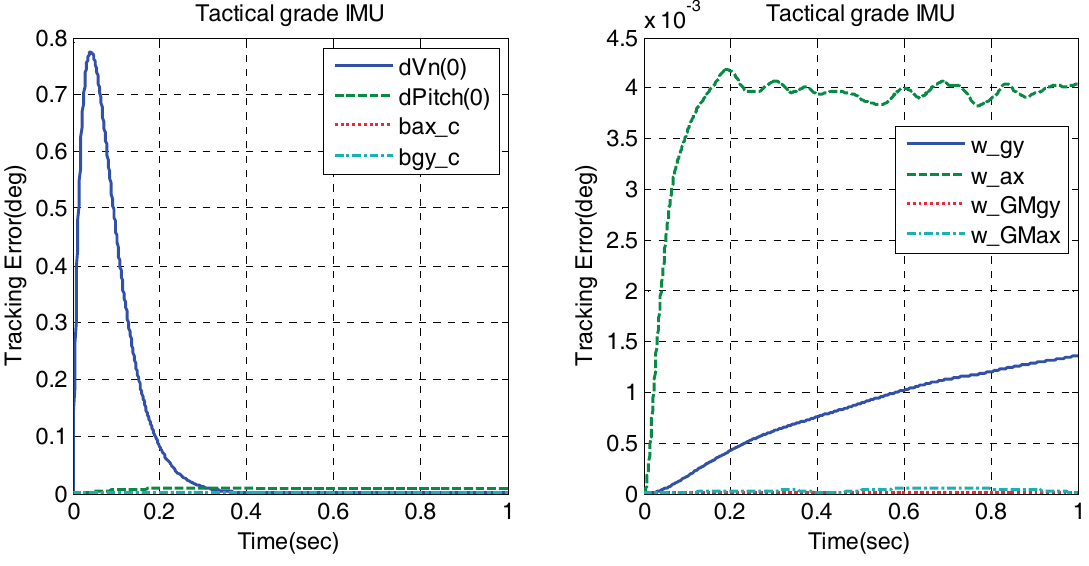
Figure 9. Carrier phase tracking errors caused by the maneuver-independent velocity error sources of tactical grade